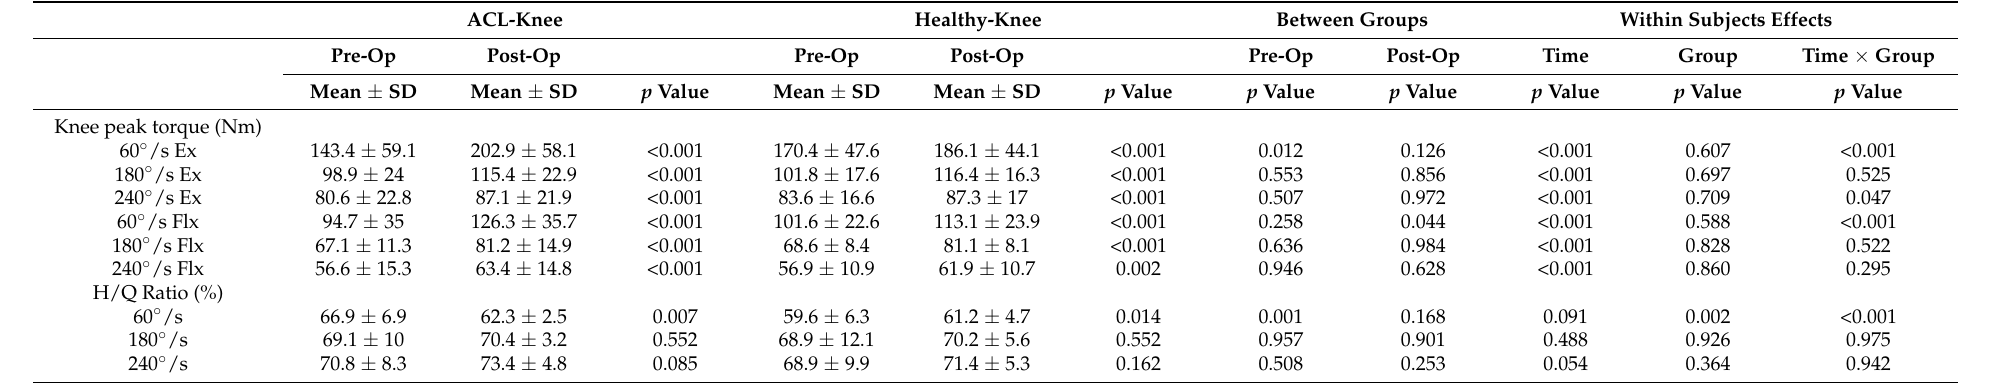
All comparisons had p -values ≥